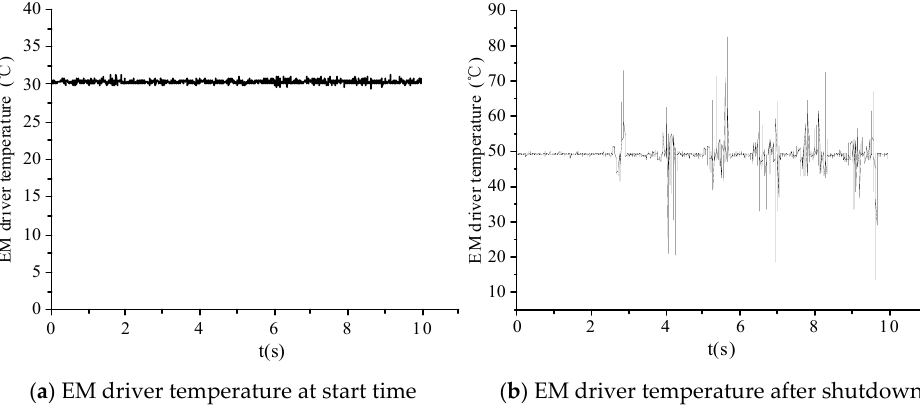
Figure 7. EM driver temperature.